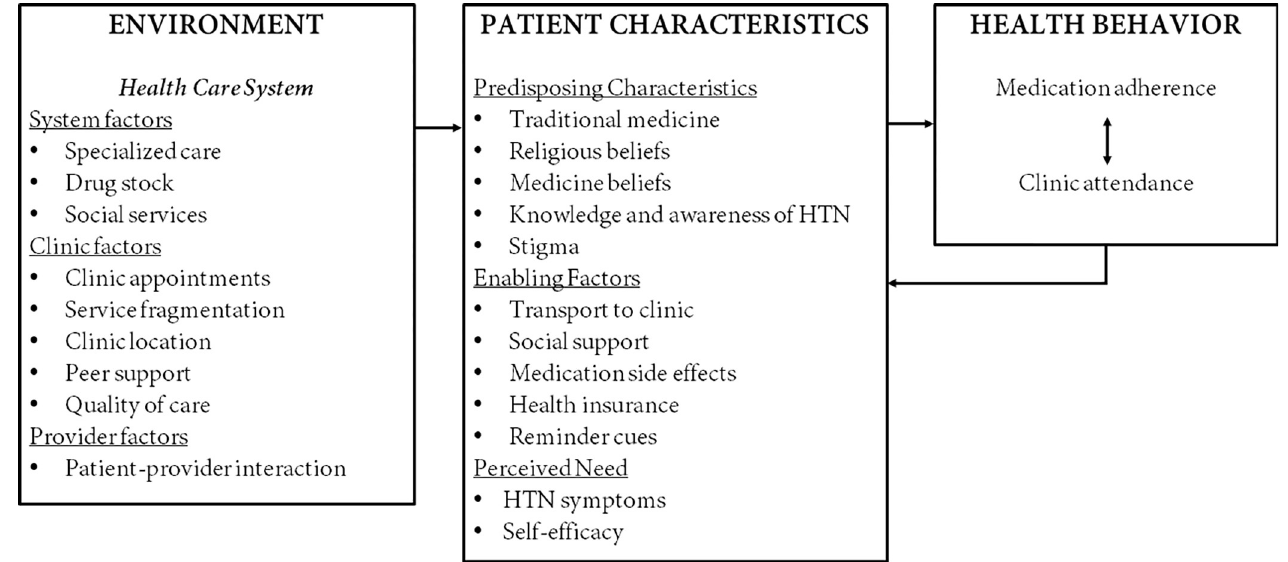
Fig 2. Barriers and facilitators for clinic attendance and medication adherence among hypertensive urgency patients in Tanzania.